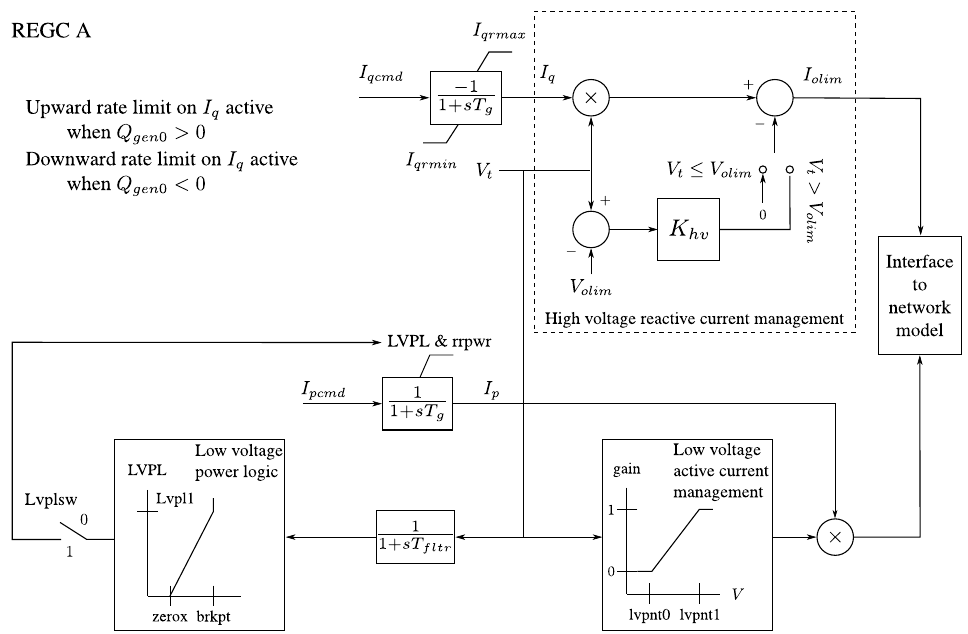
Figure 7. Second-generation PV model: generator converter